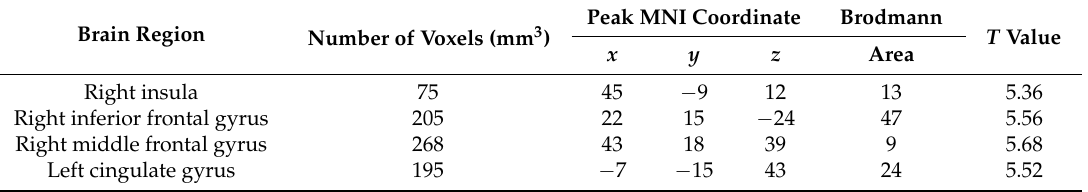
Peak MNI Coordinate z